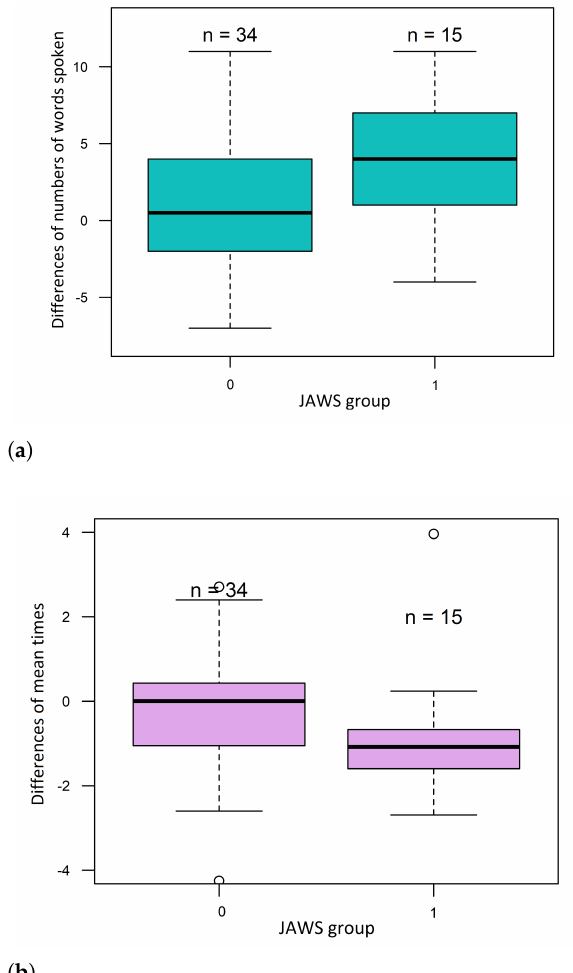
Figure 5. Boxplots of ( a ) the numbers of differences of words spoken and ( b ) the differences in mean times between